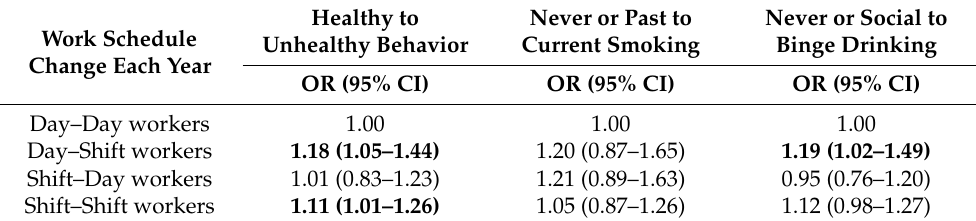
Table 3. Results of a generalized estimating equation analyzing the effect of changes in shift work schedule on changes in smoking and drinking status during the 14 year follow-up